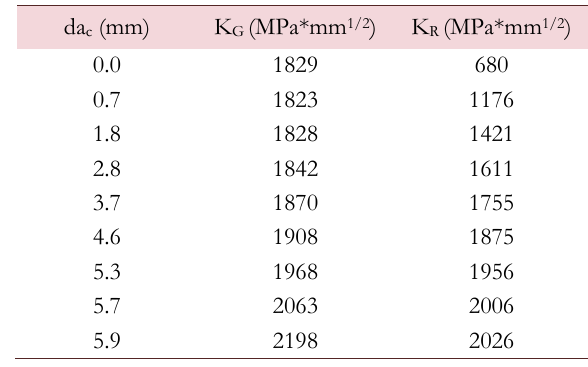
Table 2: K R , K G data for the crack tip N. 1 ( K G calculated with Irwin correction). C